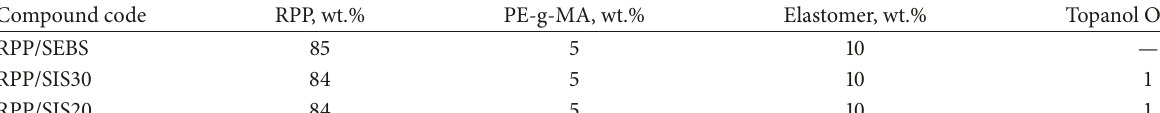
Table 1: Composition of RPP compounds.